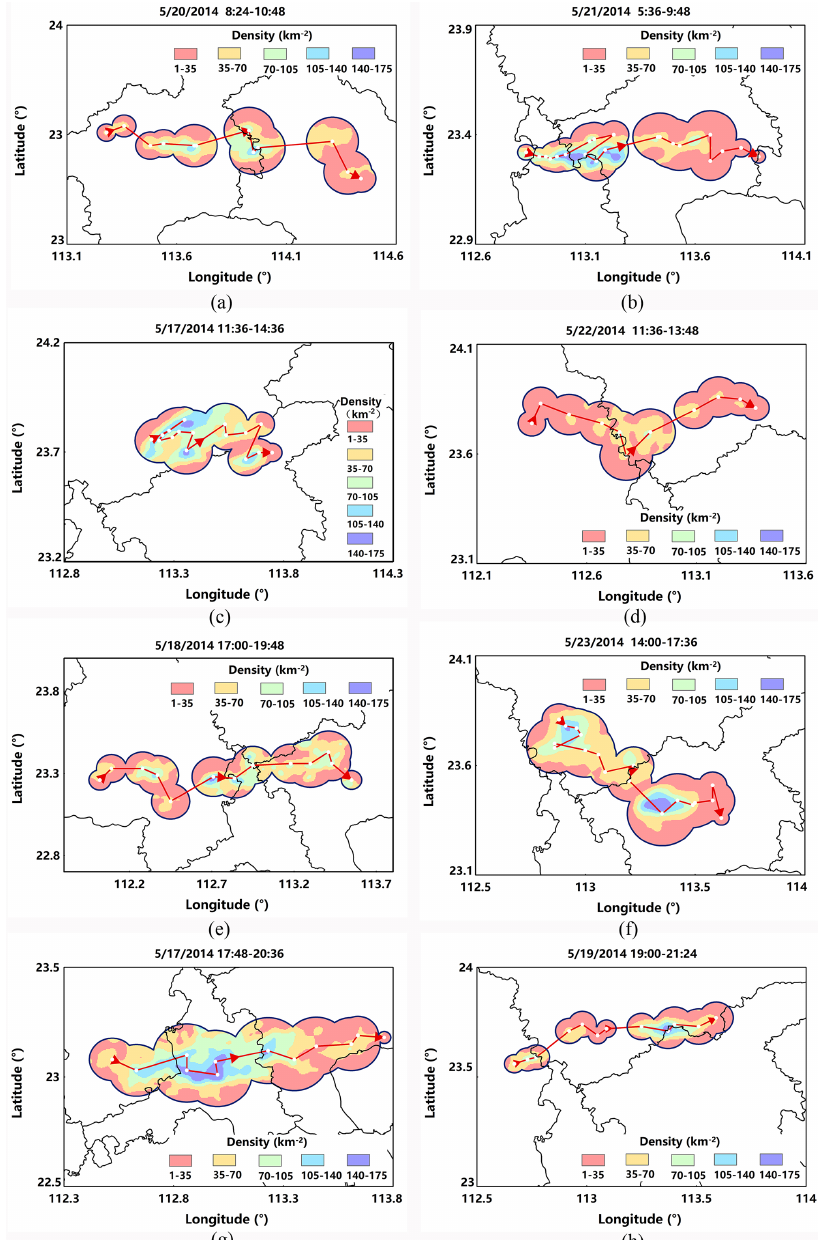
Figure 5. Ground tracks of eight thunderstorms occurring over the Pearl River Delta region in May 2014. The horizontal axis corresponds to the longitude, with the vertical axis standing for the latitude. The solid white dot is the discharge centroid of the valid area in 12min intervals. The solid red line between two dots is the general path of the thunderstorm, and the VA that the storms cover is expressed by the centroid-centred circle of a time interval. The lightning density of thunderstorms during the whole process is shown within the valid